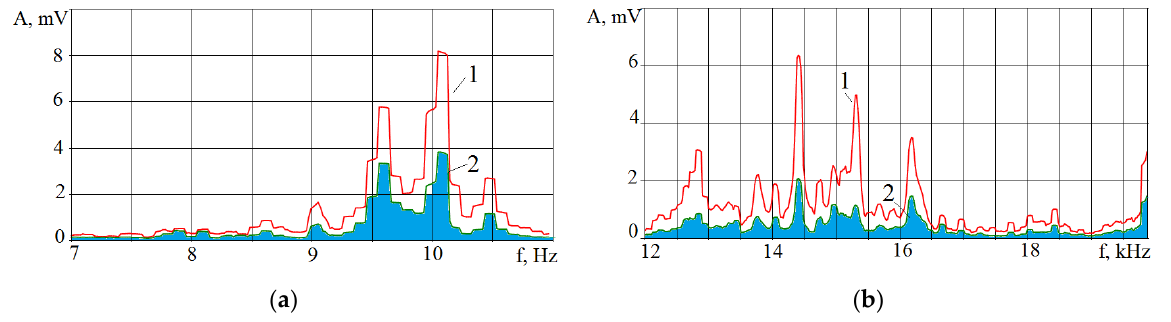
Figure 4. Comparison of the spectra of VA radiation during laser processing with a power of 60% (graphs 1) and 40% (graphs 2): ( a ) low-frequency range; ( b ) high-frequency range.